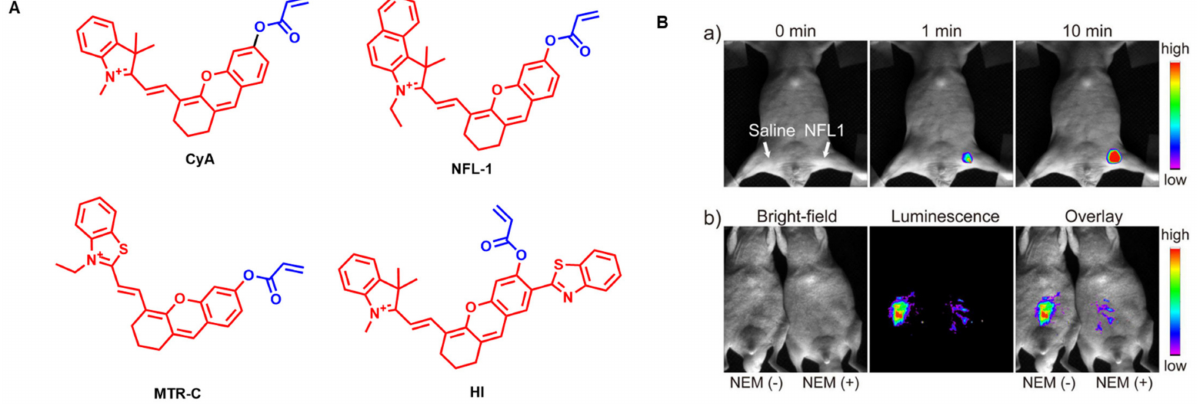
Figure 12. ( A ) Chemical structures of CyA, NFL-1, MTR-C, and HI; ( B ) In vivo NIR images of living mice via NFL1. ( a ) In vivo NIR images of living mice treated with 0.1 mL of saline (left side) or NFL1 (10 µ M, right side) solution at different times after subcutaneous injection. ( b ) In vivo NIR images of living mice. The left mice were injected with probe NFL1 (10 µ M, 0.2 mL) only for 10 min. Reproduced with permission from Ref. [78]. Copyright (2015) American Chemical Society.